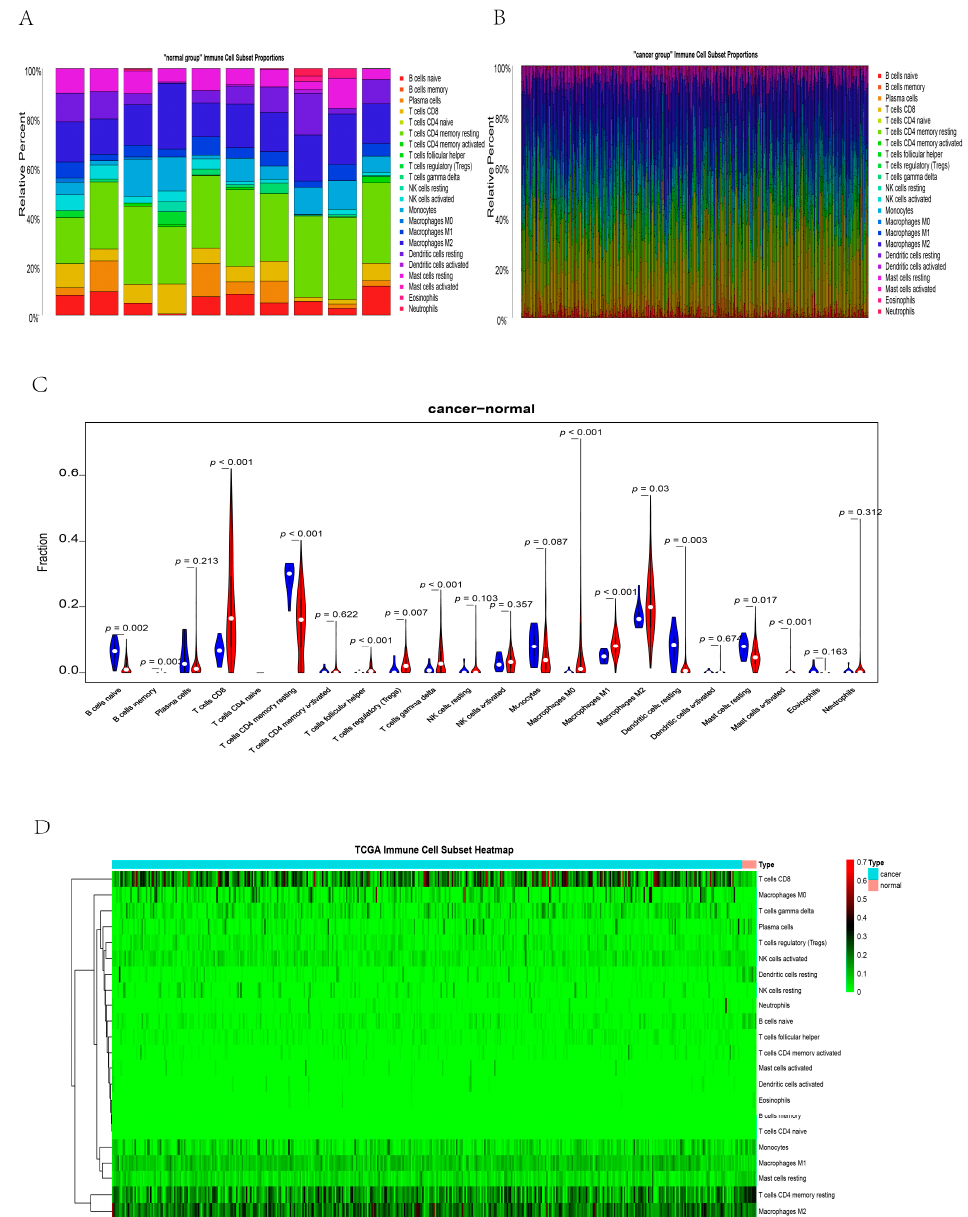
Figure 8. The difference in immune infiltration between RCC and normal tissues. ( A , B ) Stacked bar plots show the infiltration abundance of 22 immune cells in normal tissues ( A ) and RCC tissues ( B ); each bar represents one sample; macrophages and T cells account for the majority. ( C ) The violin plot illustrates the distribution of immune cells in RCC tissues and normal tissues. A large proportion of M1 macrophages, M2 macrophages, CD8 T cells, and resting memory CD4 T cells were observed in the tumor group. Resting memory CD4 T cells, M2 macrophages, monocytes, and resting dendritic cells accounted for a large part of normal tissue. B naive cells, resting memory CD4 T cells, resting dendritic cells, and resting mast cells showed greater infiltration in normal samples. ( D ) Hierarchical cluster heatmap for immune infiltration between RCC and normal tissues, each bar represents one